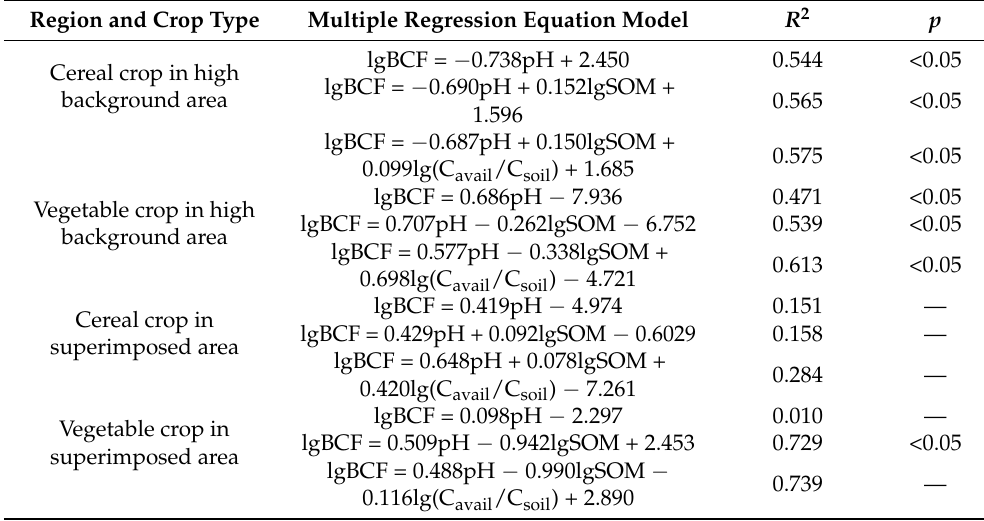
Figure 4. Soil-crop systems comprehensive pollution index in different pollution types. Note: HG represents the soil-crop system of the grain field in the high geological background area; HV represents the soil-crop system of the vegetable field in the high geological background area; MG represents the soil-crop system of the grain field in the superimposed area of the high geological background and mining activities; MV represents the soil-crop system of the vegetable field in the area where the high geological background and mining activity overlap. Table 6. Farmland Cd bioavailability model in soil-crop system under two different pollution types. Region and Crop